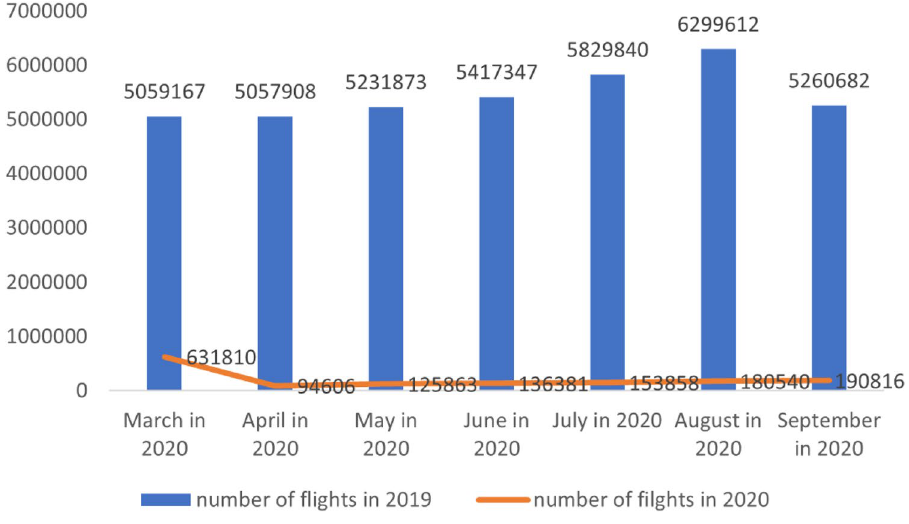
Figure 1. Total number of flights from March to September in 2019 and